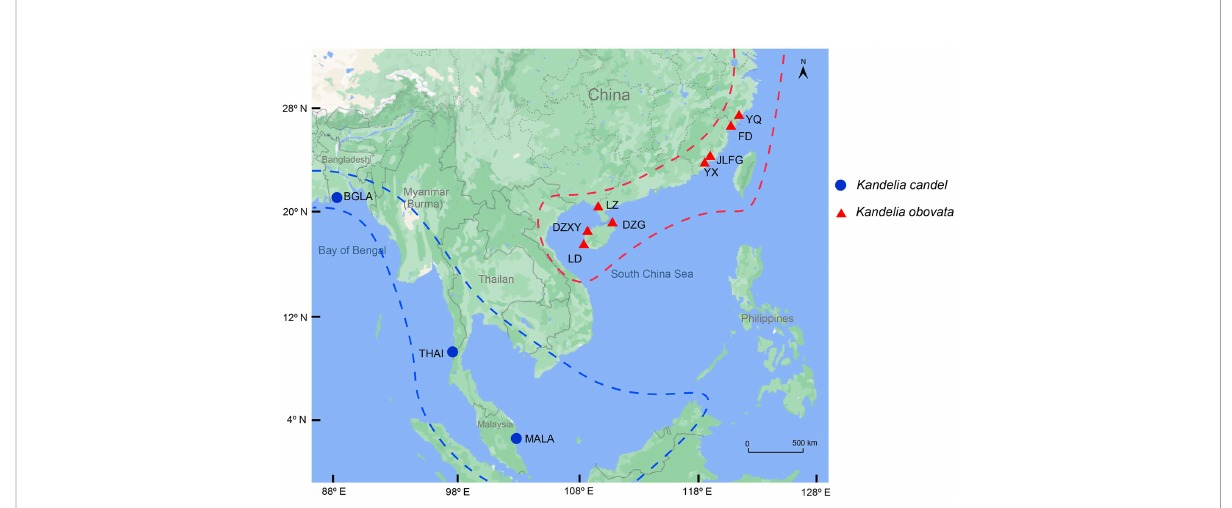
FIGURE 1 Geographic distribution of 25 Kandelia samples collected from 4 different countries including 11 sampling sites for sequencing and assembly the whole chloroplast genomes. The blue solid circle represented Kandelia candel species and the red tangle represented Kandelia obovata